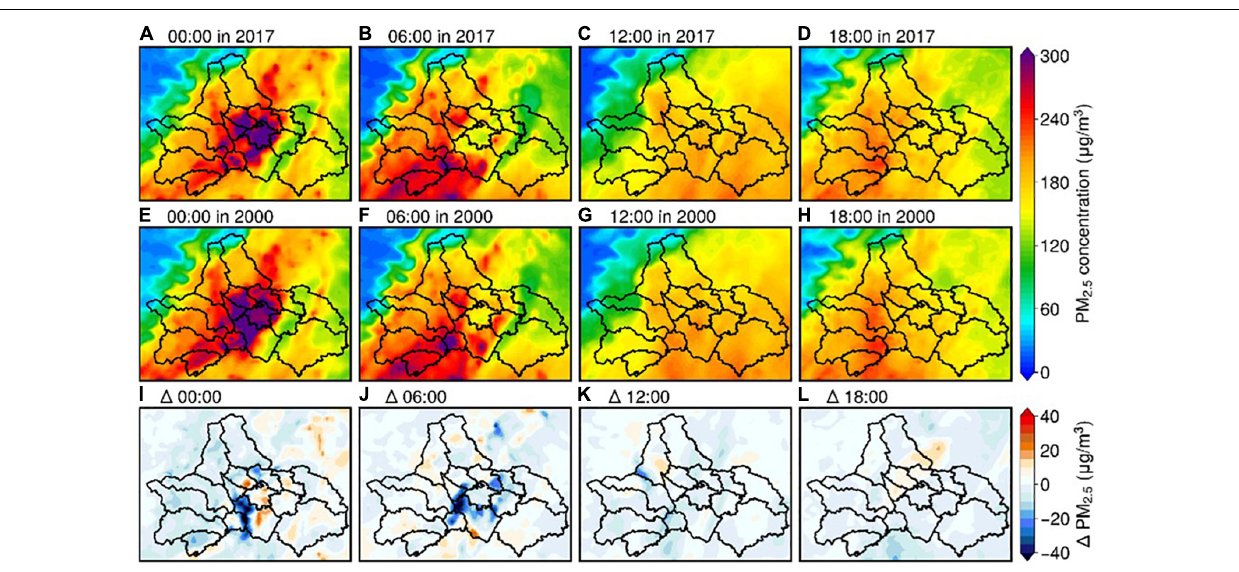
FIGURE 7 | Spatial map of simulated PM 2 . 5 levels and PM 2 . 5 variations induced by land use change between 2000 and 2017 at 00:00, 06:00, 12:00, and